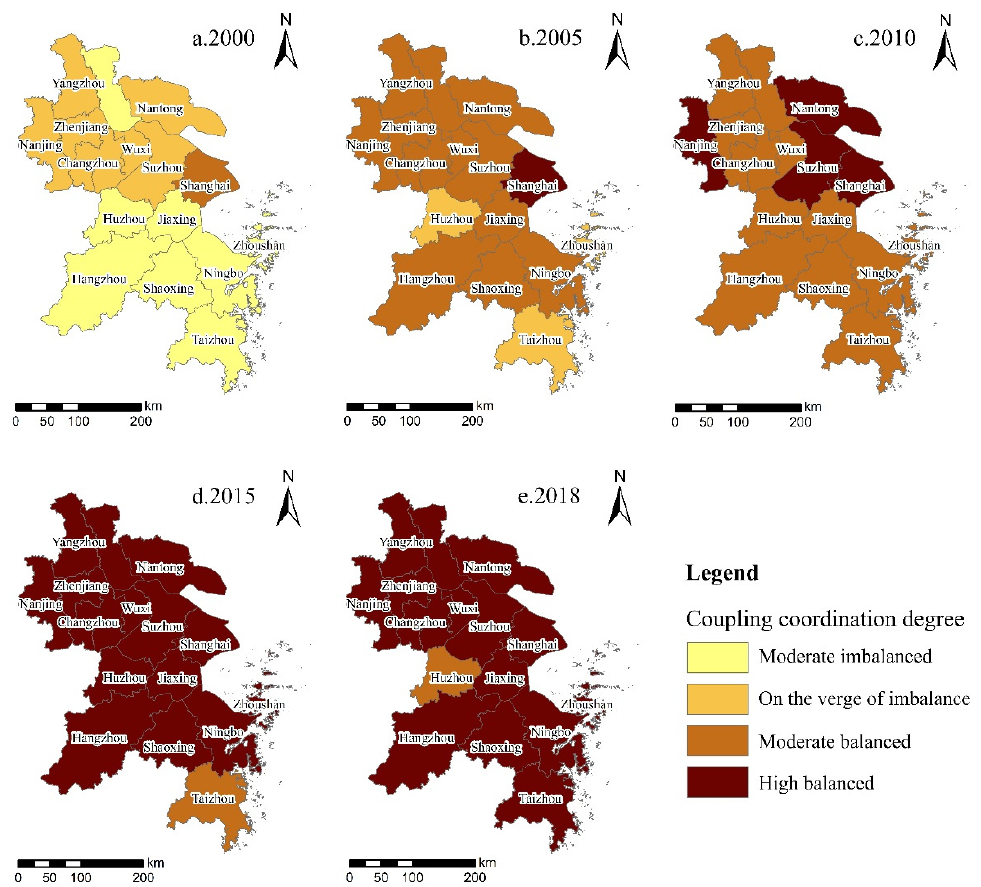
Figure 9. The spatial pattern of coupling coordination development between new-type urbanization and cultivated land low-carbon utilization of the Yangtze River Delta during 2000–2018.